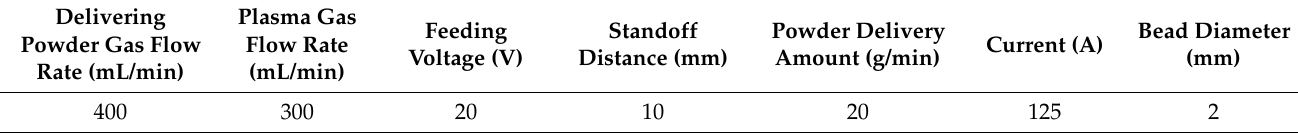
Table 2. The plasma spray welding parameters.